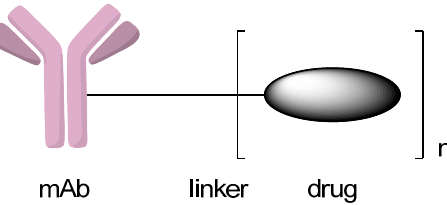
Figure 1. Schematic representation of an antibody-drug conjugate (ADC). Reprinted with permission from Reference [2].